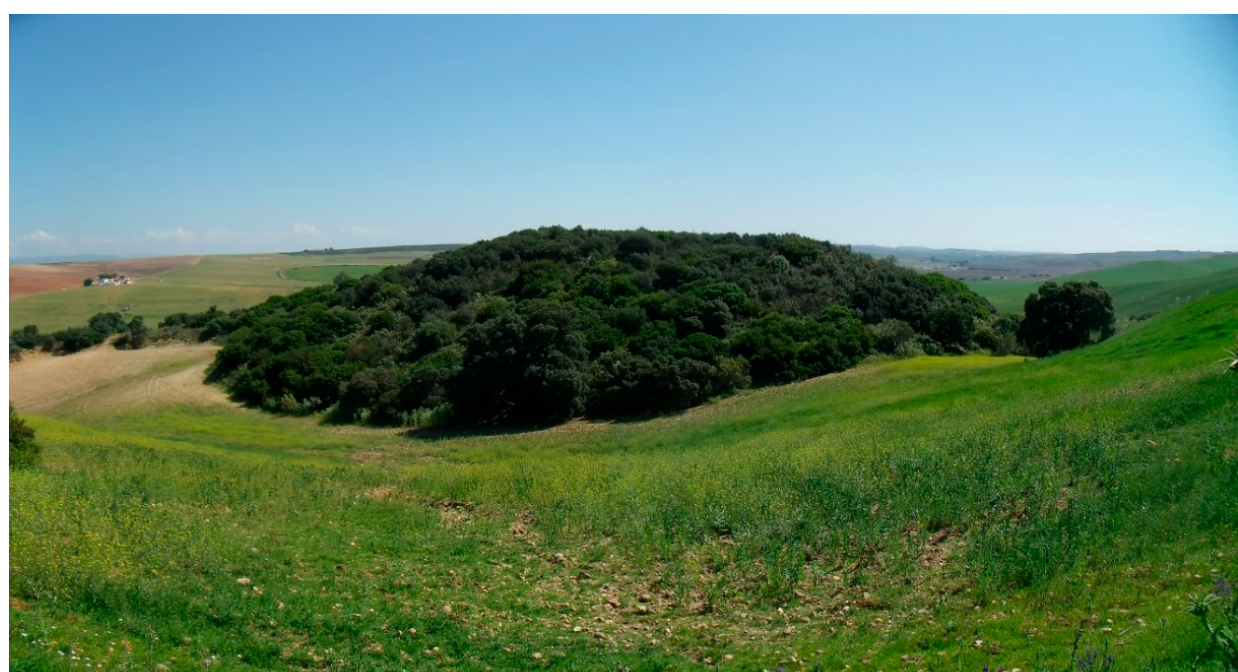
Figure 1. Picture of an Island Forest (IF) in the Guadalquivir valley (Spain) in the middle of a hostile agricultural matrix. The structure of this patch is a forest of holm oak trees accompanied by dense scrubland.